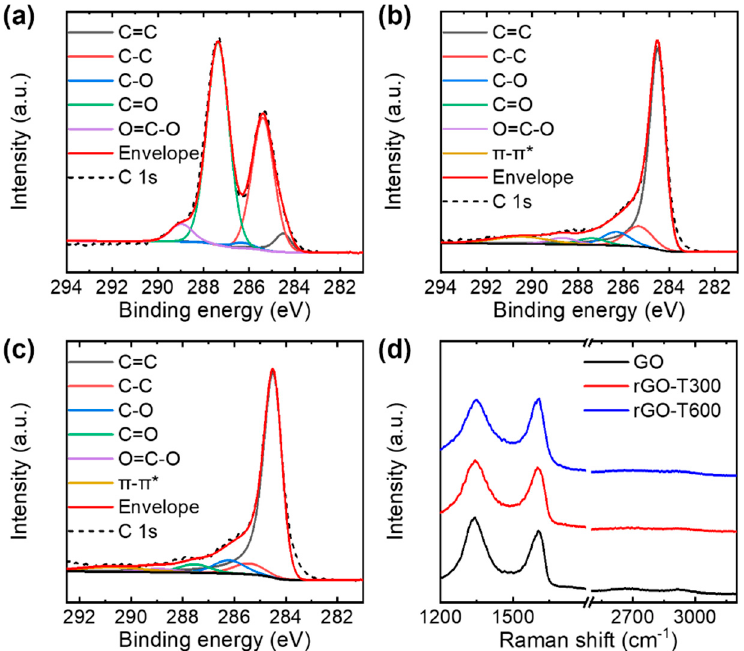
Figure 5. ( a – c ) XPS C 1s spectra of ( a ) GO and ( b , c ) rGO flakes. Thermal annealing was performed at ( b ) 300 and ( c ) 600 °C. ( d ) Raman spectra of GO and rGO flakes. rGO-T300 and rGO-T600 denote rGO flakes annealed at 300 and 600 °C, respectively.